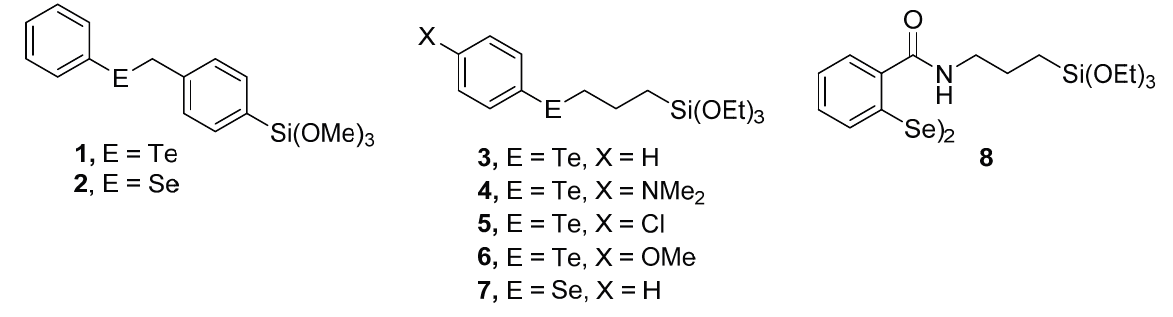
Figure 1. Organochalcogenides used as catalysts or catalyst precursors in xerogel